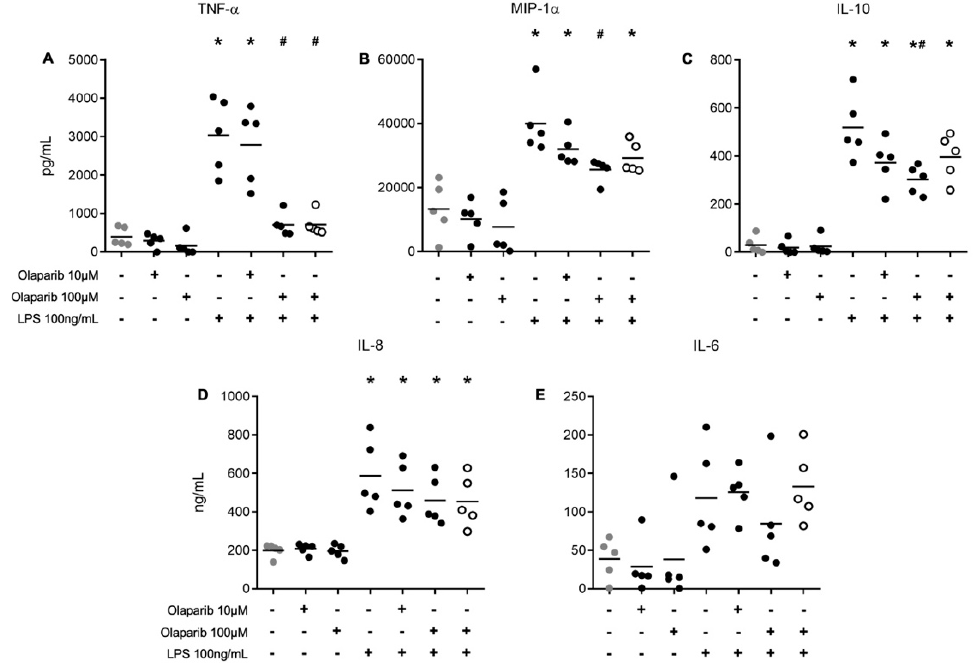
Figure 4. Measurement of cytokines secreted by human PBMCs. PBMCs from five healthy volunteers were incubated for 24 h with or without LPS (100 ng/mL). Cultures were untreated, or olaparib (10 or 100 µ M) was added 30 min before exposure to 100 µ M LPS (closed symbols). The last group (open symbols) represents the results of the experiments when olaparib (100 µ M) was administered 30 min after LPS (as opposed to the pretreatment paradigm applied in the rest of the protocol). Culture supernatants were examined at 24 h. The results for IL-6 were obtained by ELISA assay (ng/mL). The results for TNF- α ( A ) MIP-1 α ( B ), IL-10 ( C ), and IL-8 ( D ) were obtained by the CBA assay (pg/mL) and by ELISA for IL-6 ( E ). * p < 0.05 compared to the control condition. # p < 0.05 compared to the LPS 100 ng/mL condition (ANOVA followed by Tukey test).